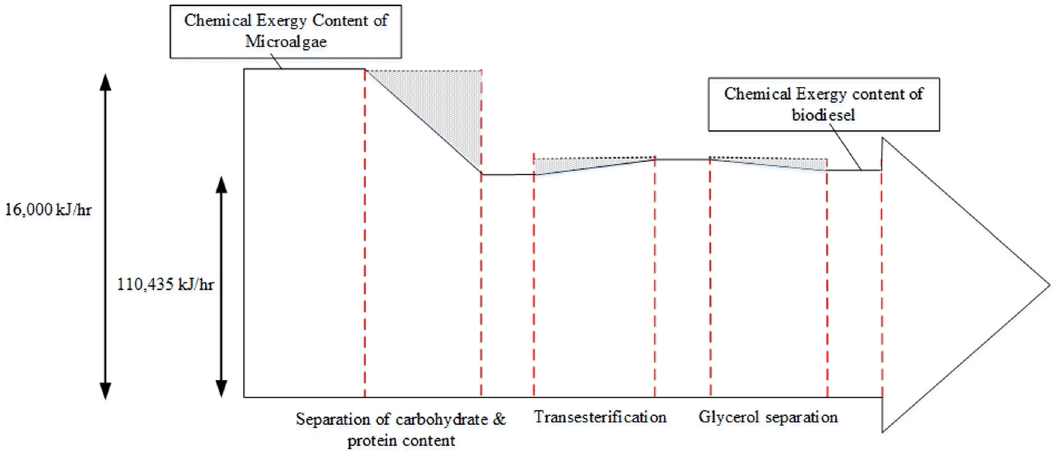
Figure 6: Biodiesel production process fl ow diagram of HTL - esteri fi cation